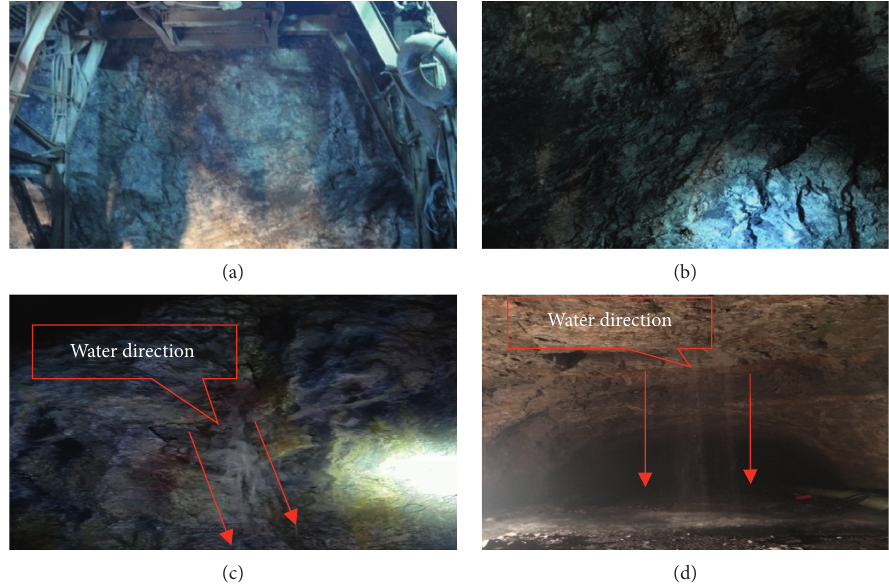
Figure 8: Geological analysis of the tunnel face. (a) Overall drawing of the tunnel face. (b) Right side of the tunnel face. (c) Water gushing from cracks on the left side of the tunnel face. (d) Water pouring downward from the